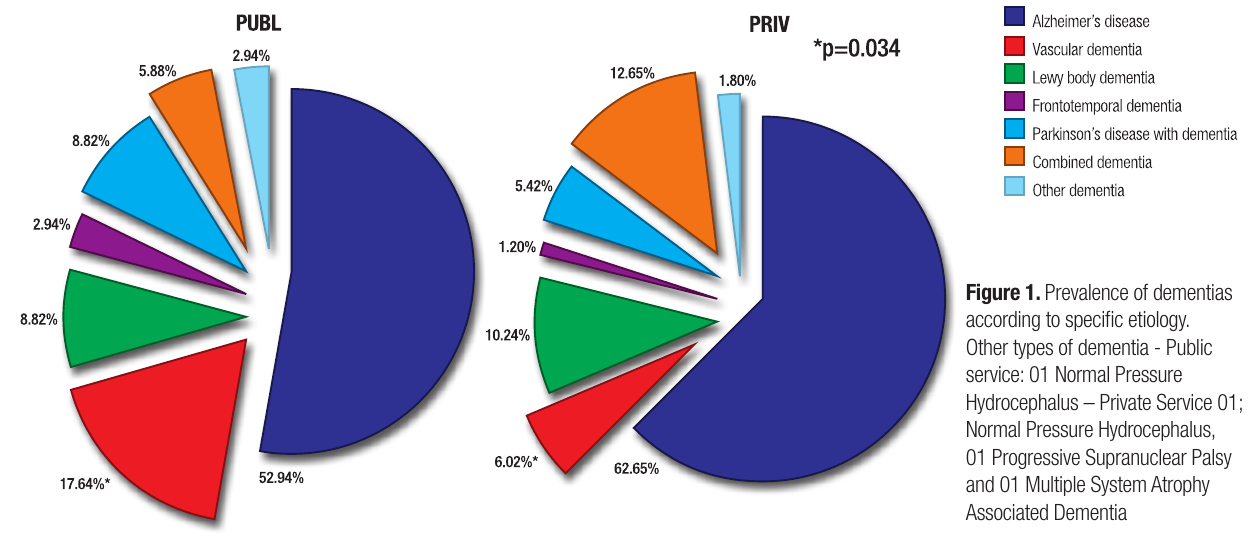
Figure 1. Prevalence of dementias according to specific